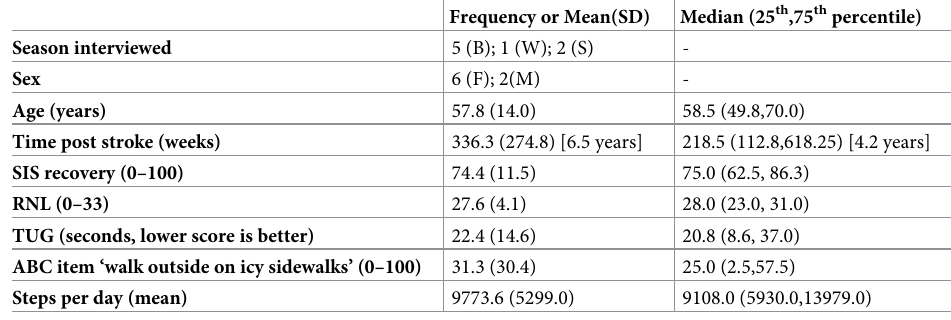
B = both seasons, W = winter, S = summer; SIS = Stroke Impact Scale; RNL = Return to Normal Living